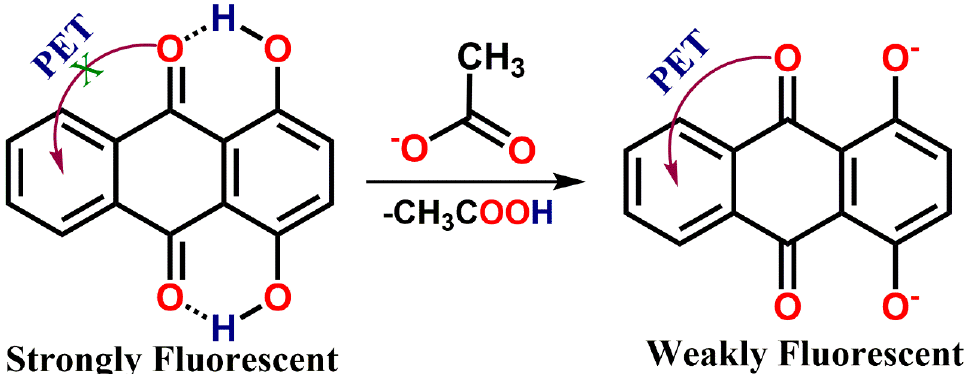
Figure 3. ( A ) The changes in fluorescence emission intensity of QZ (10 μ M) after the addition of different anions (90.9 μ M). ( B ) The competitive binding ability of QZ towards CH 3 COO − ions in the co-existence of other anions. ( C ) The relative changes in emission intensity of QZ after increasing the concentration of CH 3 COO − . ( D ) Corresponding Stern–Volmer plot.